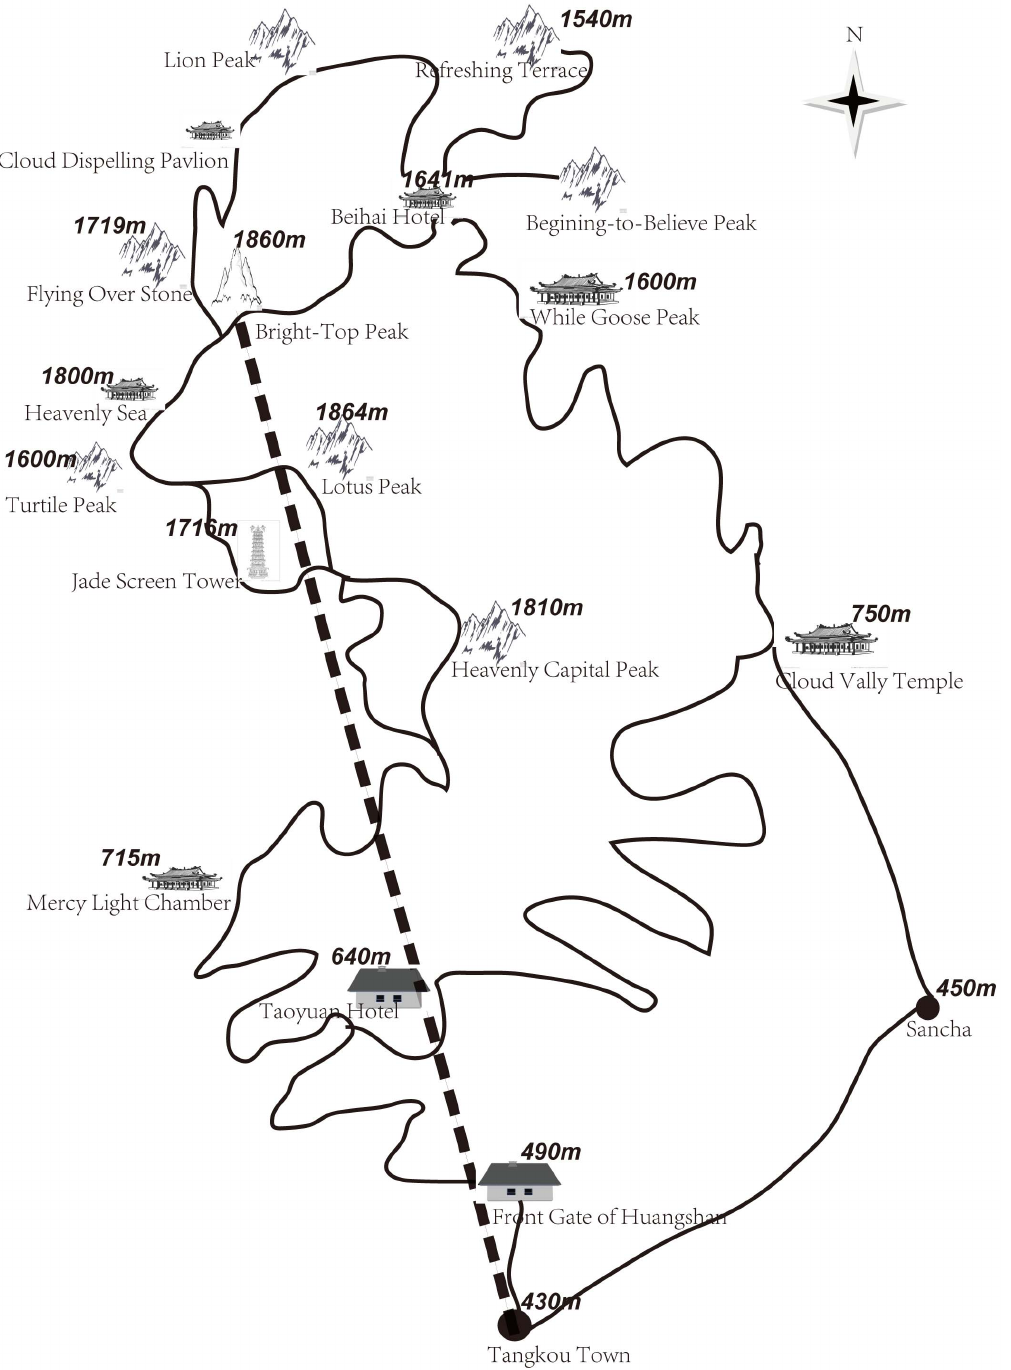
Figure 1. Overview of the Huangshan Mountain sampling strategy. Note: The transect line (dotted line) started at the town of Tangkou (430 m) and ended at Bright Top Peak (1,820 m). doi:10.1371/journal.pone.0101106.g001 zone and the P. hwangshanensis zone ( Nm = 17.8659), however, was significantly higher than for any other pairwise comparisons.